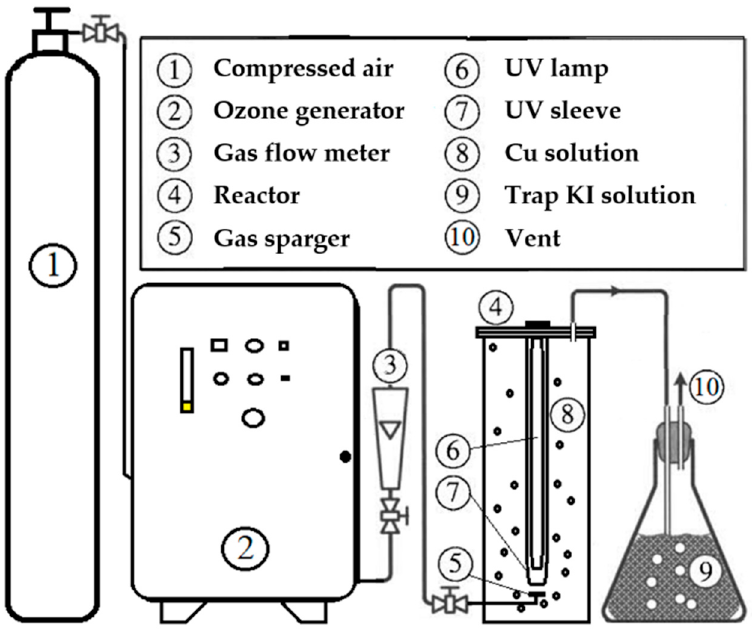
Figure 1. Schematic diagram of UV-Ozone treatment equipment.